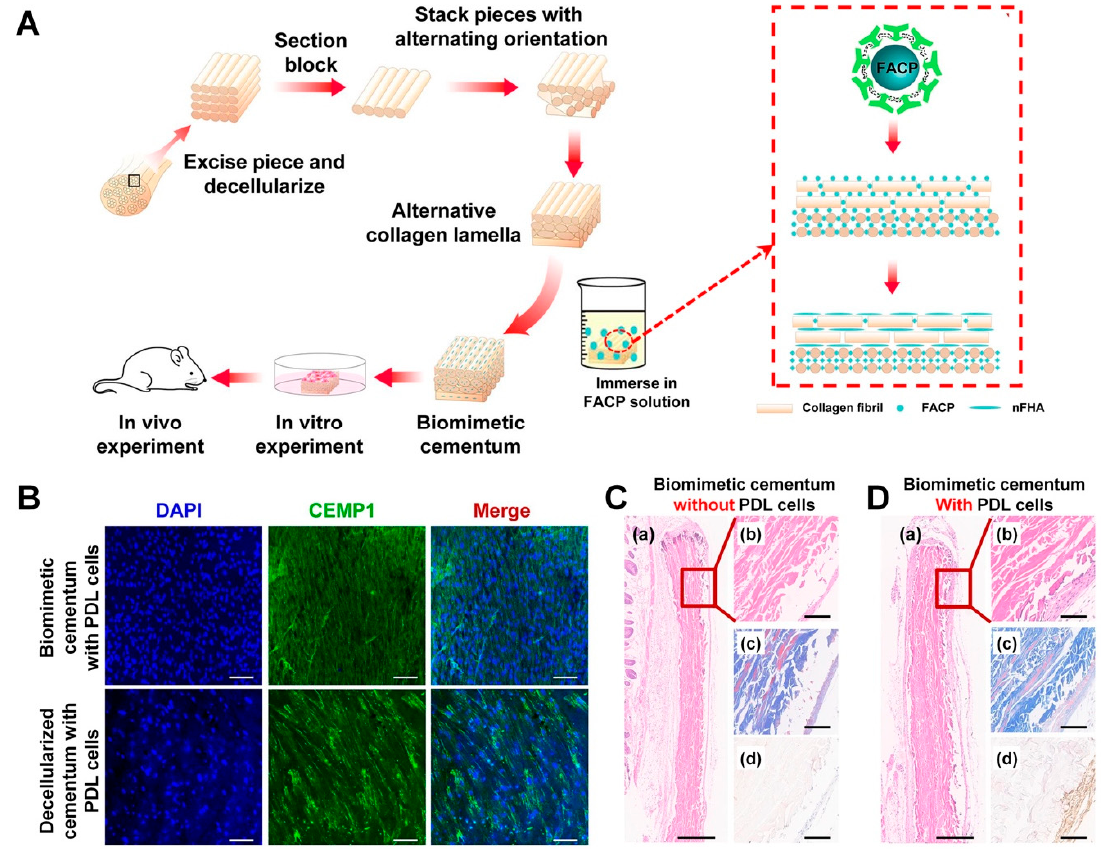
Figure 8. The biomimetic cementum construction with fluorine, which could catalyzed biomineral formation in in-vitro and in-vivo. The schematic illustration demonstrated Bioskiving process with fluorine containment for biomineralization and the constructs of biomimetic cementum were examined in in-vitro and in-vivo ( A ). In in-vitro experiments, two di ff erent constructs (biomimetic cementum and decellularized human cementum) had similar expression levels of CEMP-1 after seeding periodontal ligament (PDL) cells ( B ). In-vivo study showed that biomimetic cementum structure could stimulate cementogenic di ff erentiation of PDL cells and promote cementogenesis to form mineralized layer formation ( C-d , D-d ). Hematoxylin and eosin (H&E) staining analyzed tissue morphologies with two di ff erent magnifications (low magnification ( C-a , D-a ) and high magnifications ( C-b , D-b )). Masson trichrome staining was used for collagen and bone (( C-c , D-c )). Immunohistochemical analysis was qualitatively analyzed for cementogenesis using CEMP-1 ( C-d , D-d ). Scale bar: 100 µ m. Adapted with permission from the reference [185].